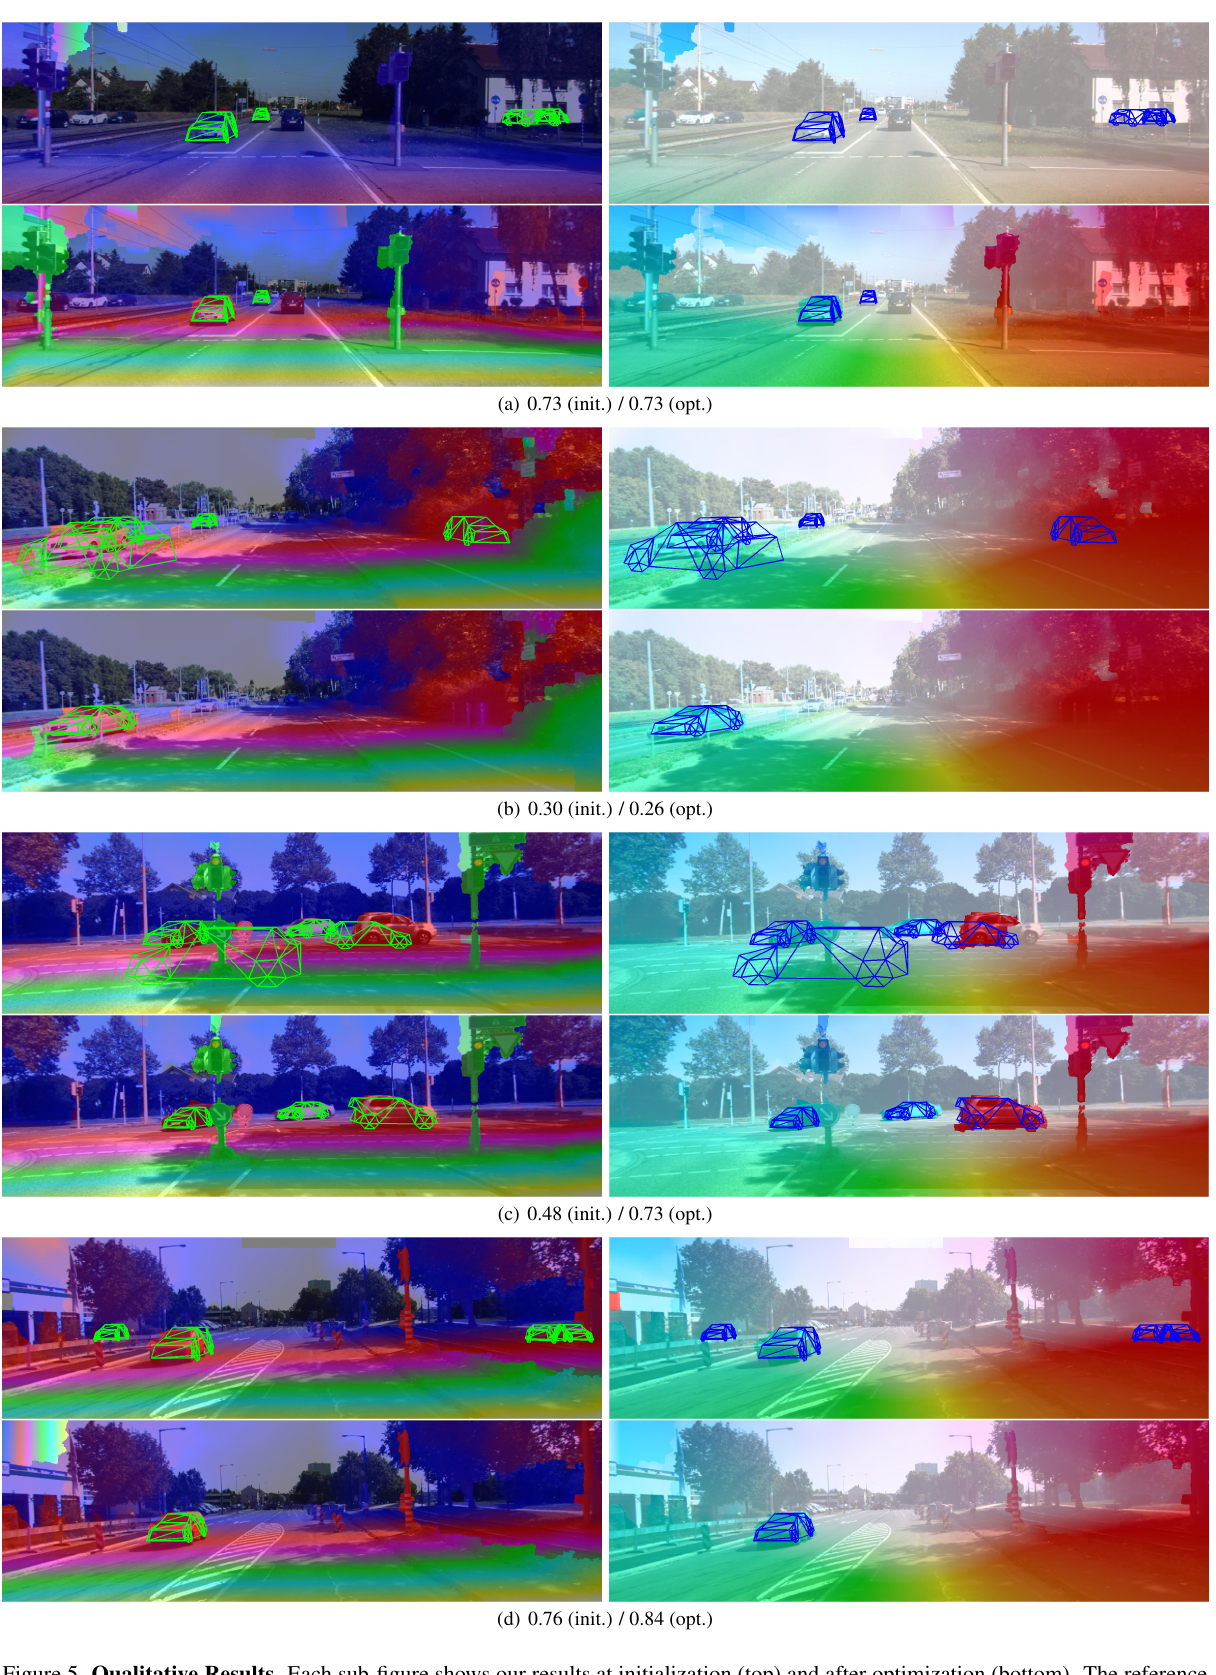
Figure 5. Qualitative Results. Each sub-figure shows our results at initialization (top) and after optimization (bottom). The reference view is superimposed with the color-coded disparity (left) and optical flow map (right). Object models are depicted as green and blue wire-frames. The numbers in the sub-captions specify the value of the intersection-over-union criterion at initialization and after